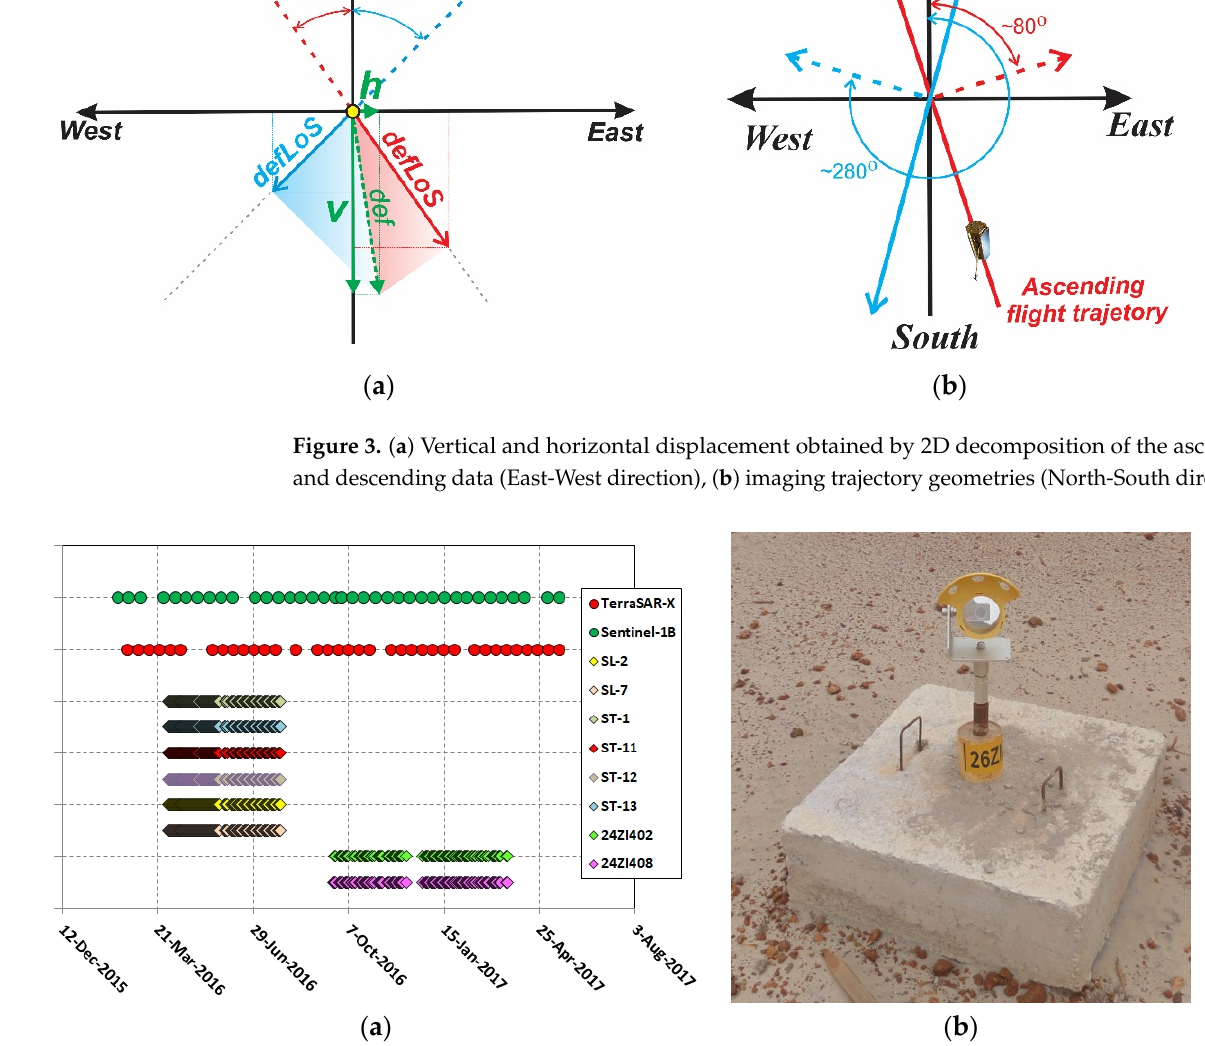
Figure 4. ( a ) Plot of acquisition of TSX and S1B images and topographic surveying with prisms; ( b ) Example of prism used on the topographic surveying. ( b ) Example of prism used on the topographic